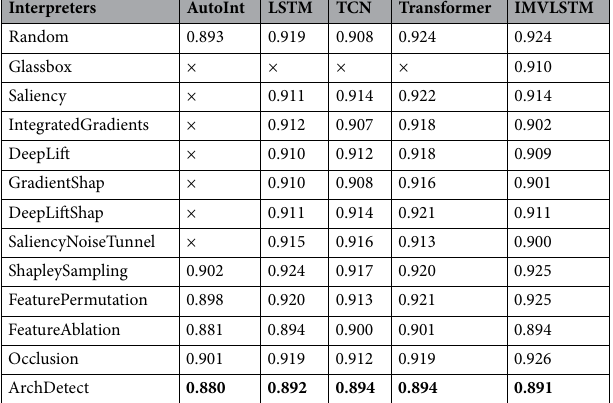
Table 5. Area under the curve (AUC) of interpretability methods for each model and the model trustworthiness metric evaluated using ROAR. Lower AUC indicates more rapid trustworthiness drop. Lower is better. Best values are in